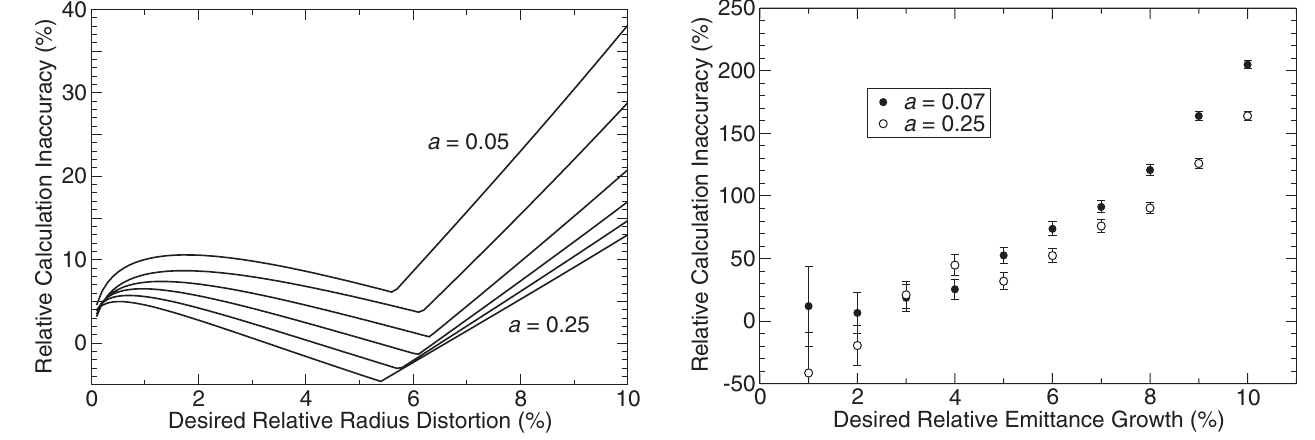
FIG. 12. Relative inaccuracy in the calculation of the emit- tance growth (cid:1) (cid:4) vs the desired value of (cid:1) (cid:4)=(cid:4) , for two different values of a . Error bars show 1 (cid:6) uncertainties due to the finite number of particles integrated.